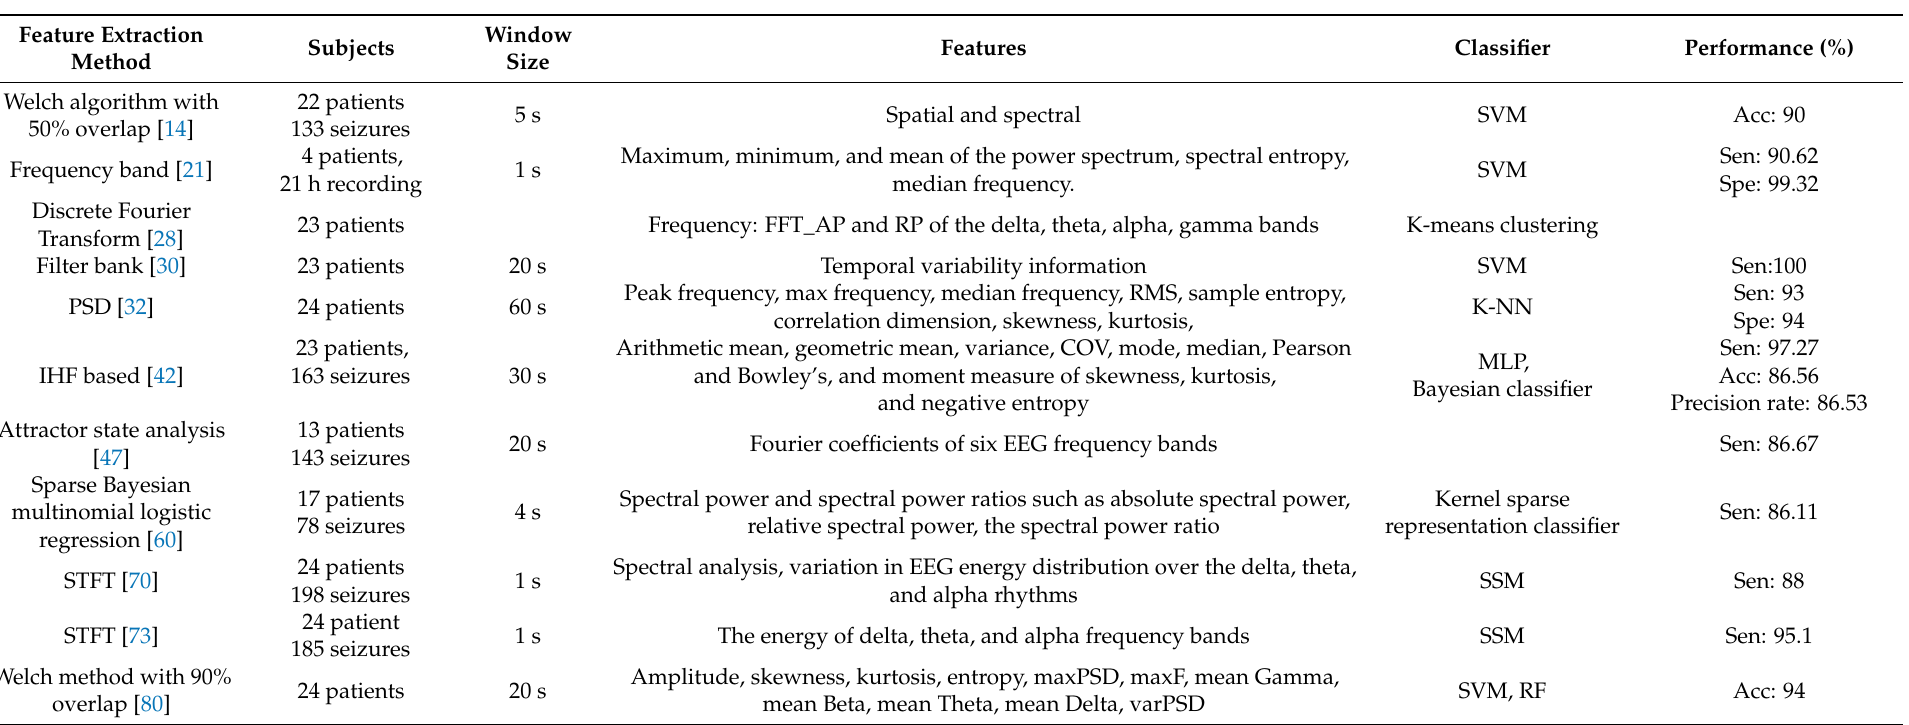
Table 2. Summary of epileptic seizure detection approaches in the frequency